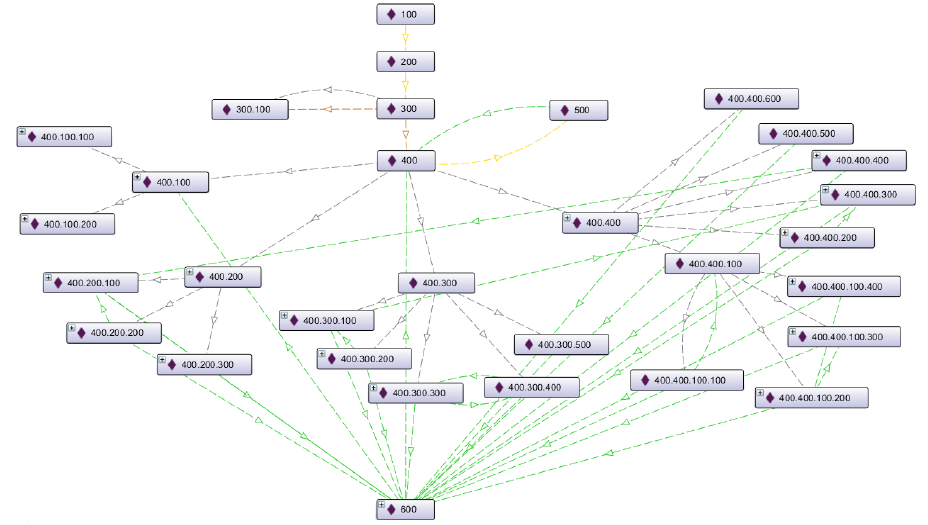
Figure 4. The semantic diagram of the chatbot